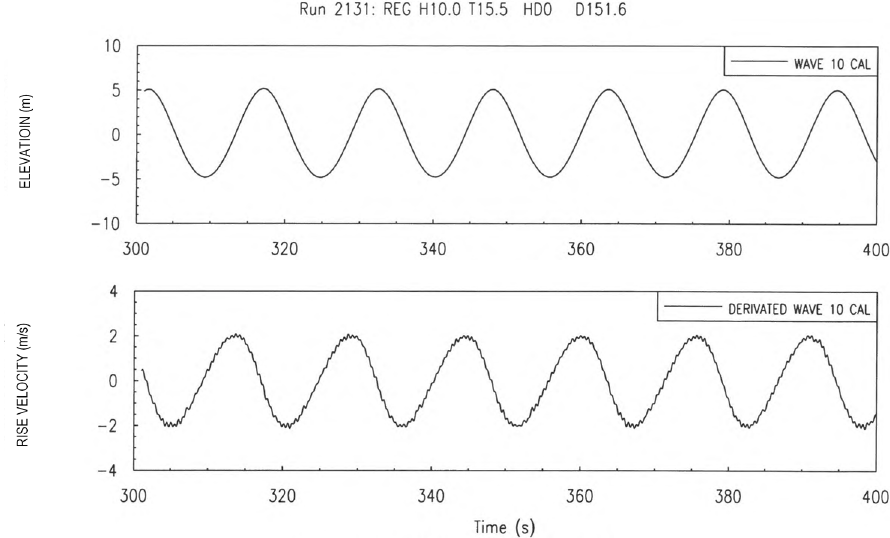
Figure 9. ( Top ): Measured incident wave elevation for a low regular wave H = 10 m, Tp = 15.5 s. ( Bottom ): Corresponding rise velocity derived from the elevation.